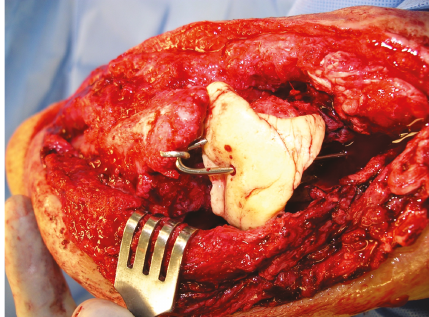
5: Intraoperative photograph of the implanted amphotericin, vancomycin, and tobramycin-impregnated cement